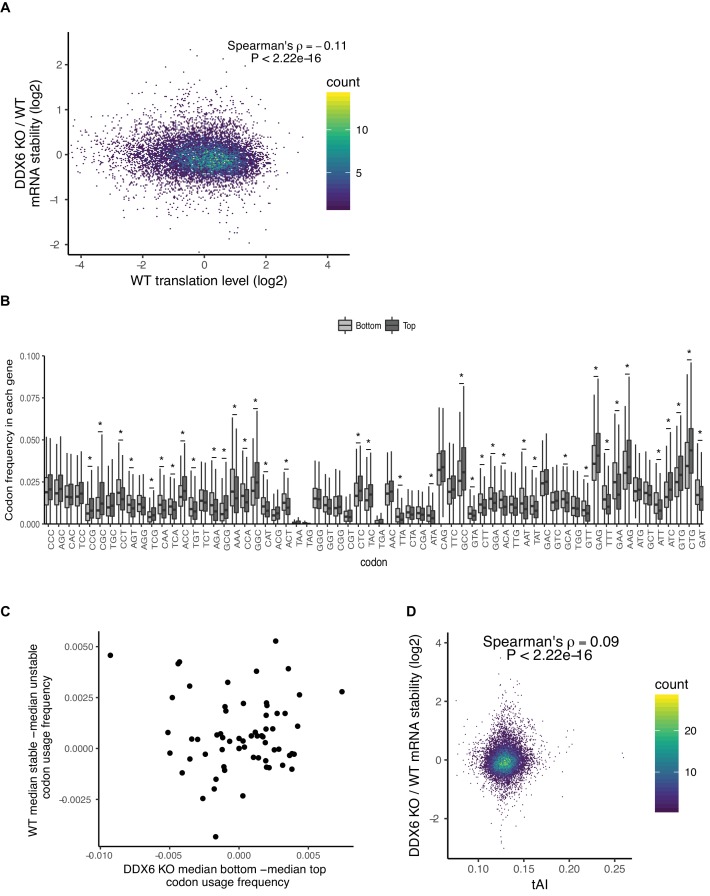
Connection between stability changes and translation.(A) mRNA stability changes in Ddx6 KO cells versus wild-type translation level. (B) Boxplots showing the codon usage frequency in the top and bottom 20% of mRNA stability changes in Ddx6 KO for unstable genes as defined in Figure 2—figure supplement 1E. * indicates p<0.05 calculated using the Mann–Whitney test followed by Bonferroni correction. (C) Difference in median codon frequency between stable and unstable transcripts in wild-type cells versus difference in median codon frequency between top and bottom Ddx6 KO mRNA stability changes. (D) mRNA stability changes in Ddx6 KO cells versus species-specific tRNA adaptation index (tAI) scores for each gene.